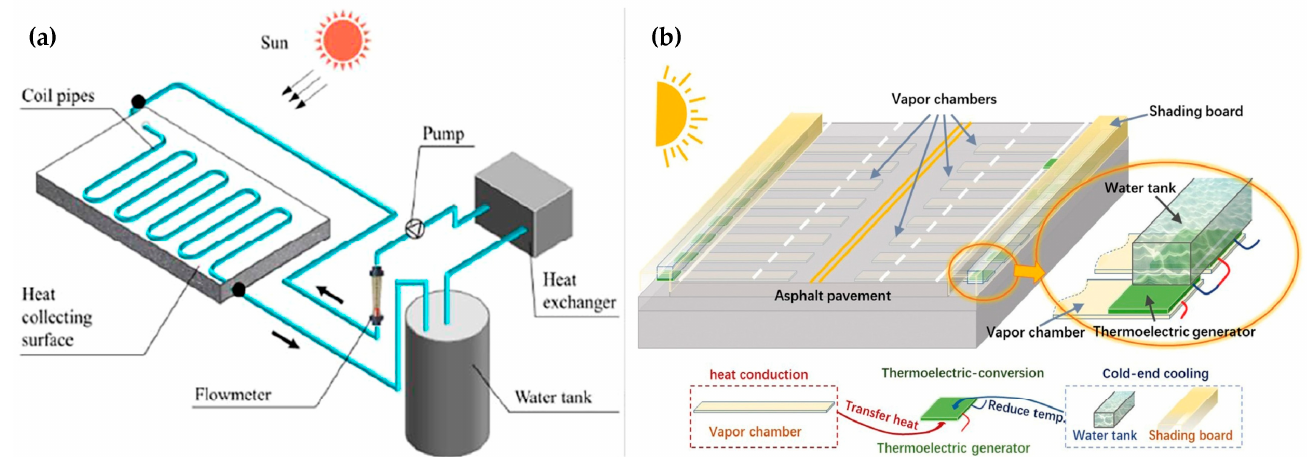
Figure 7. Schematics of PSC implementations: ( a ) The water tank collects heated fluid, and the heat exchanger releases the heat into the environment (Reprinted with permission from Ref. [66]. 2019, Elsevier) [66]. ( b ) Road thermo-electric generator system (RTEGS) to convert heat into electrical energy, as presented in [67] (Reprinted with permission from Ref. [67]. 2018, Elsevier).